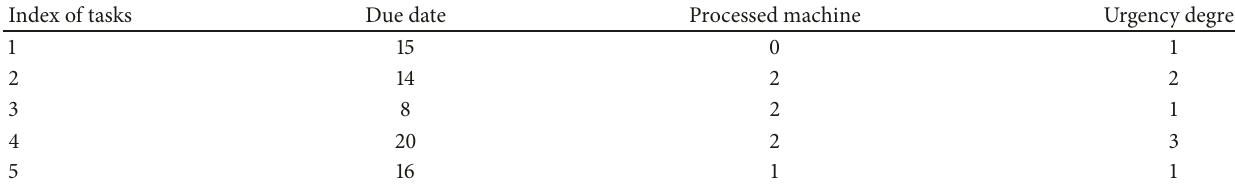
Table 1: An example of urgency degree.